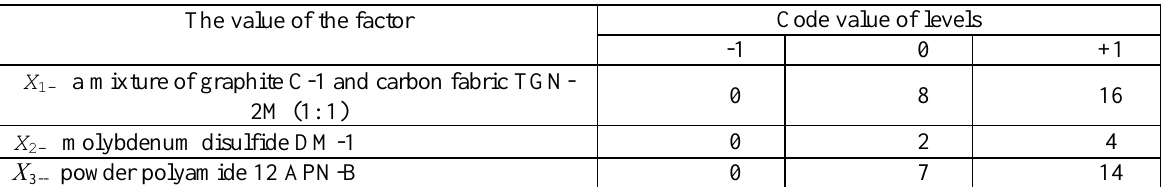
Levels of variation of